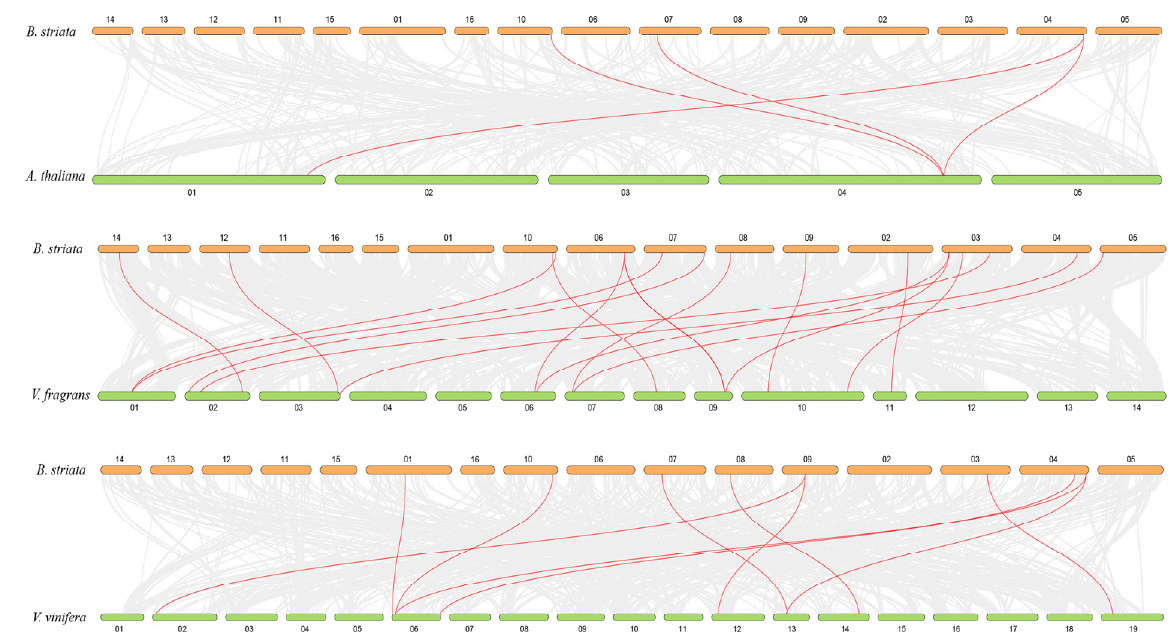
Figure 5. Synteny analysis of MADS genes between B. striata and three other plants ( A. thaliana , V. fragrans , and V. vinifera ): gray lines indicate the collinear blocks within the B. striata genome and the other genomes, while the red lines indicate MADS gene pairs.